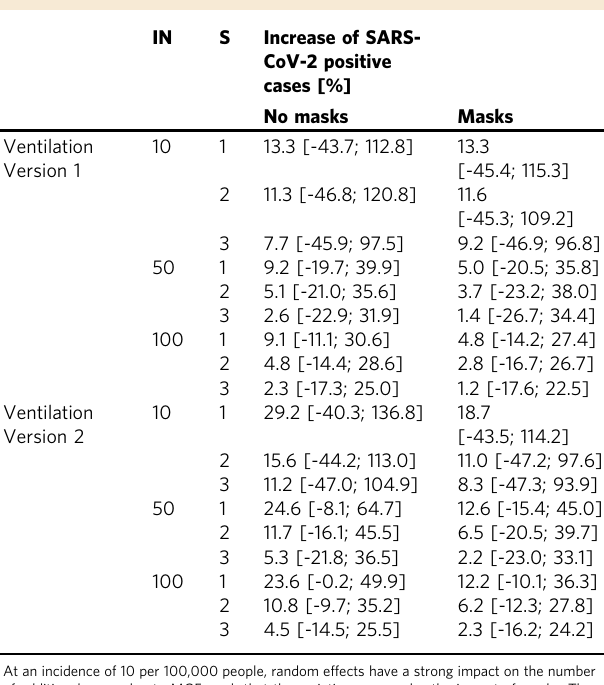
Table 3 Increase in SARS-CoV-2 positive cases in percentage that acquired the infection during the mass gathering events